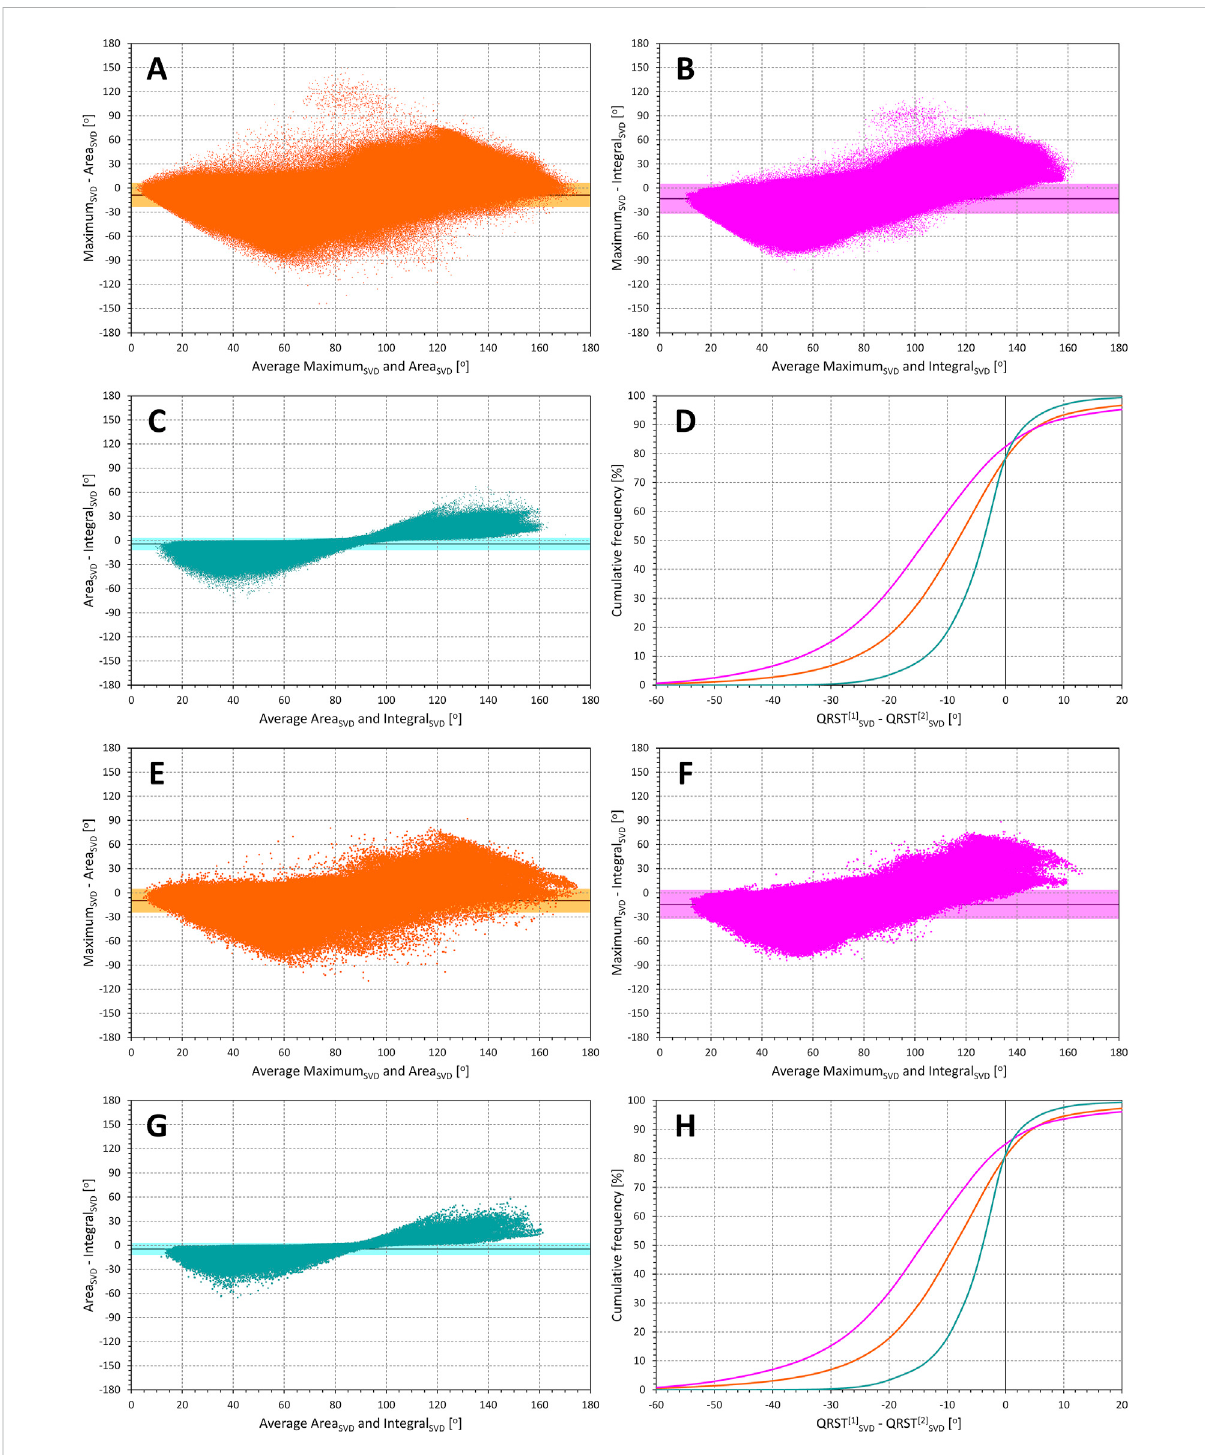
FIGURE 4 Comparisons of methods of QRS-T angle measurements in SVD orthogonal projections. Bland-Altman type of comparisons betweendifferent QRS-Tangle methodsappliedto theorthogonal leads derivedbysingularvaluedecompositionoftheoriginal12-leadECGsignals. Thelayout ofthe Figure and the meaning of individual panels is the same as in Figure 3 but methods Maximum SVD , Area SVD , and Integral SVD were analysed instead of Maximum XYZ , Area XYZ , and Integral XYZ ,